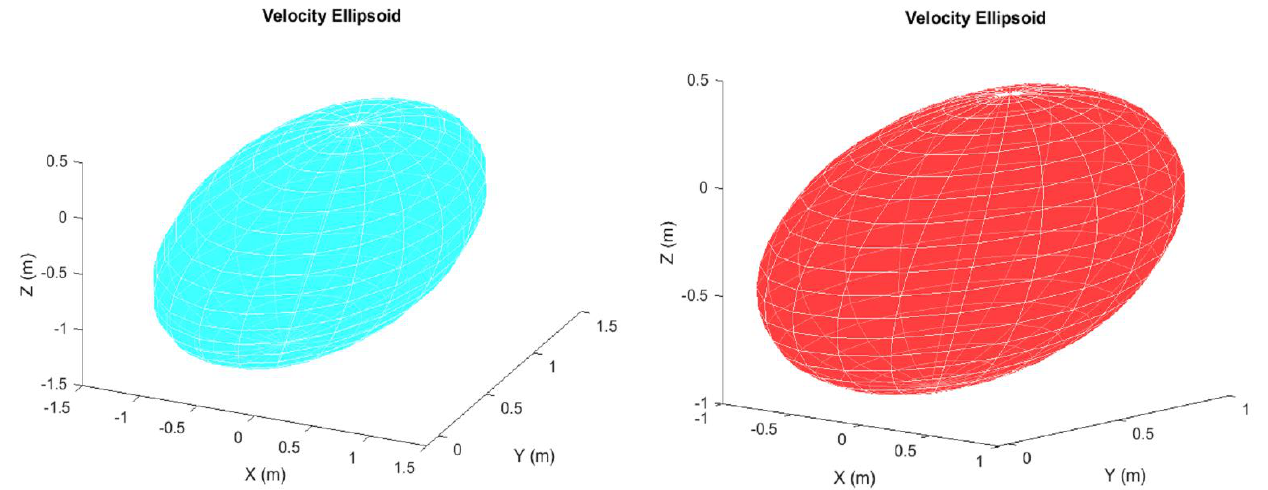
Figure 16. Velocity ellipsoid of the joint angles corresponding to the middle waypoint configuration ( left ) and final pose configuration ( right ).